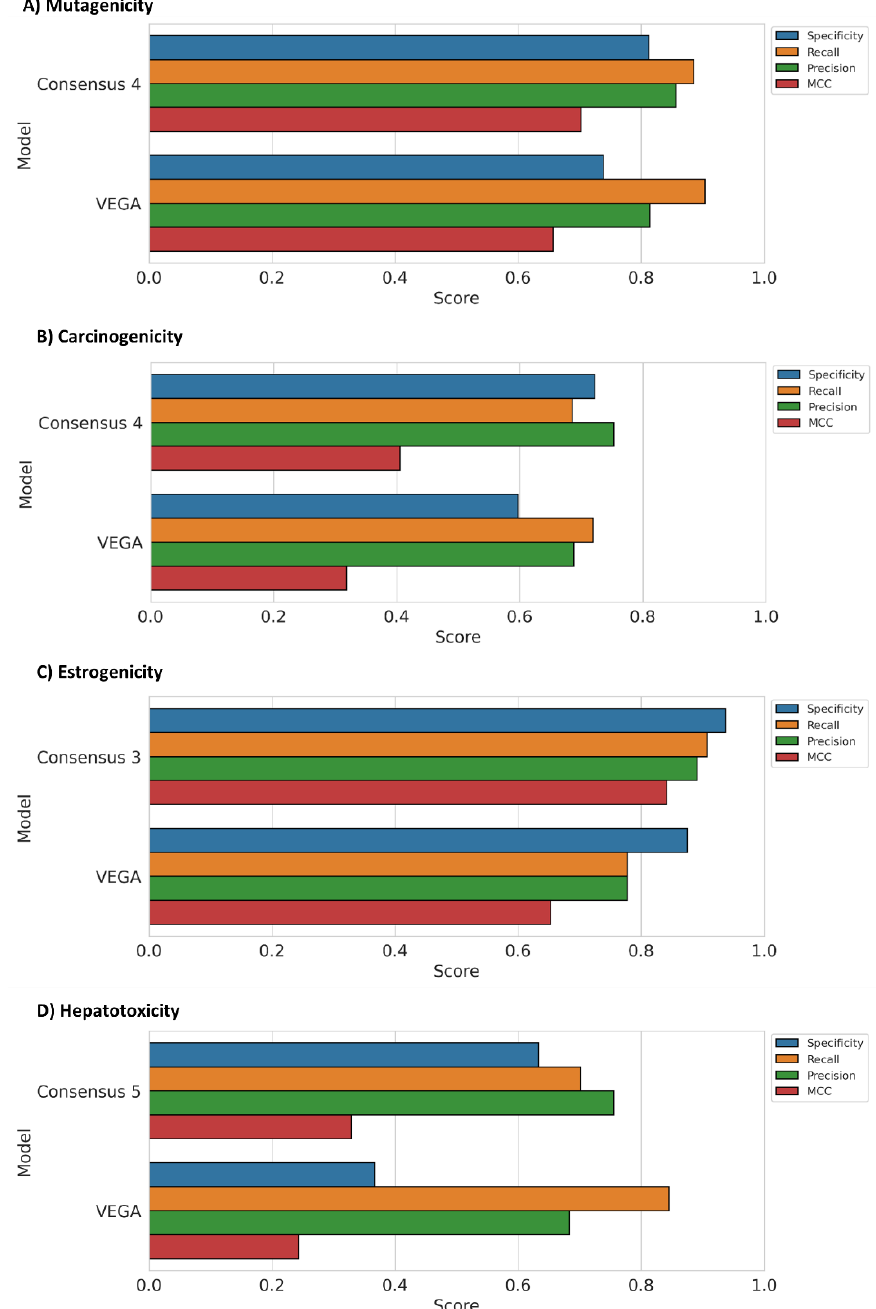
Figure 3. Statistical values obtained with the consensus strategy for the ( A ) mutagenicity, ( B ) carcinogenicity, ( C ) estrogenicity and ( D ) hepatotoxicity endpoints, compared with the reference models included in VEGA.